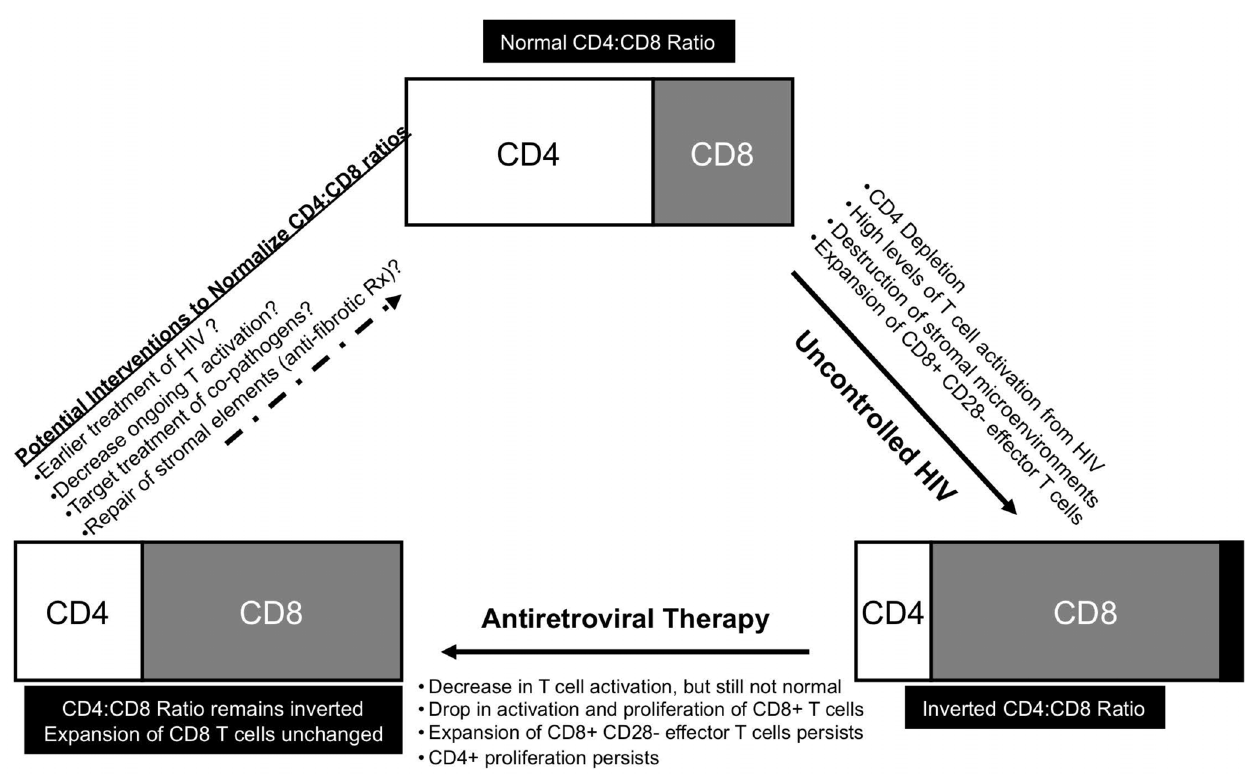
Figure 6. Schema of CD4:CD8 ratio in HIV infection. Uncontrolled HIV infection results in depletion of CD4 + T cells with concomitant increase in CD8 + T cells, mostly of an effector phenotype. This process is largely driven by high levels of T cell activation. With introduction of antiretroviral therapy, there is a decrease in T cell activation and a resulting drop in activation and proliferation of CD8 + T cells. There is also some recovery of CD4 + T cells. However, an inverted CD4:CD8 ratio persists due to persistently expanded CD8 + T cell